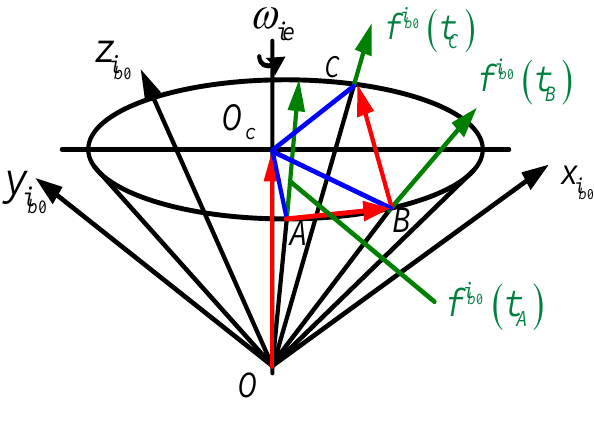
Figure 4. Calculation method for cone